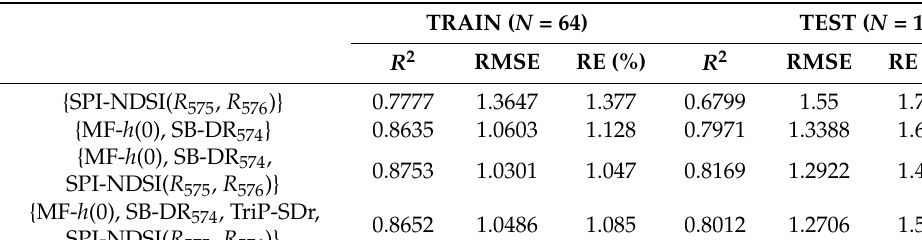
Figure 3. Average of R 2 for the combinations containing different variables. Table 5. The best model of different parameter combinations.